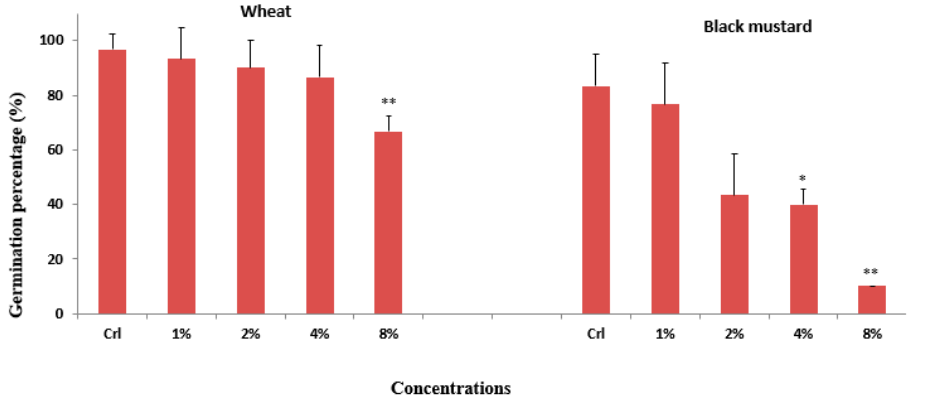
Figure 2. Effect of the aqueous extract of H. persicum on seed germination in wheat and black mustard determined on the ninth day of the experiment. * = significant and ** = highly significant. Crl = Control, No stars on the bars means there is no significant change.